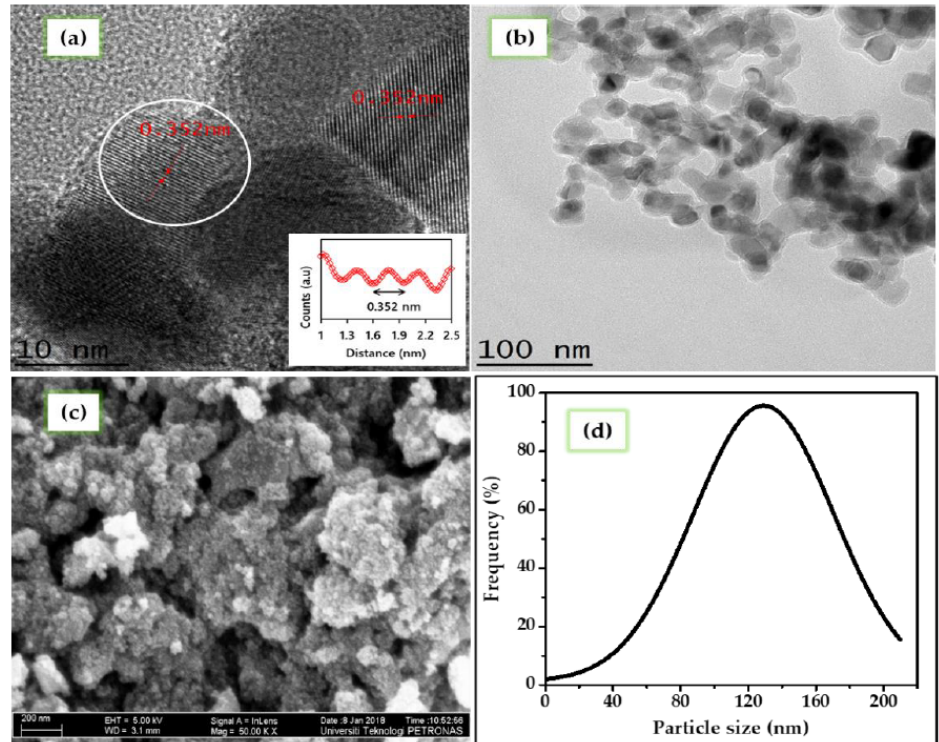
Figure 4. ( a ) High Resolution Transmission Electron Microscopy image (inset, result of line analysis), ( b ) Transmission Electron Microscopy Image, ( c ) Field Emission Scanning Electron Microscopy image, and ( d ) particle size distribution of the TiO 2